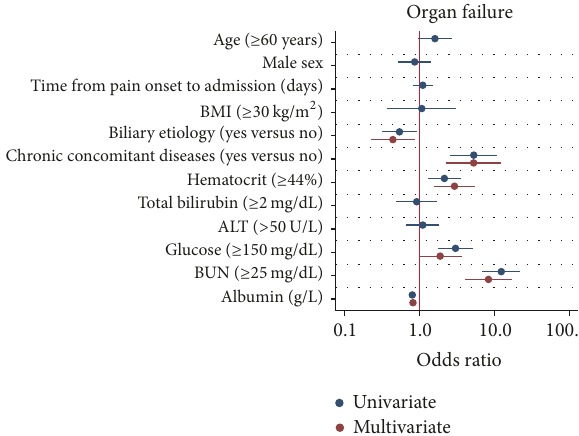
Figure 2: Univariate and multivariate logistic regression plot of odds ratios and 95% confidence intervals for evaluation of the relationship between serum albumin level and persistent organ failure in acute pancreatitis.